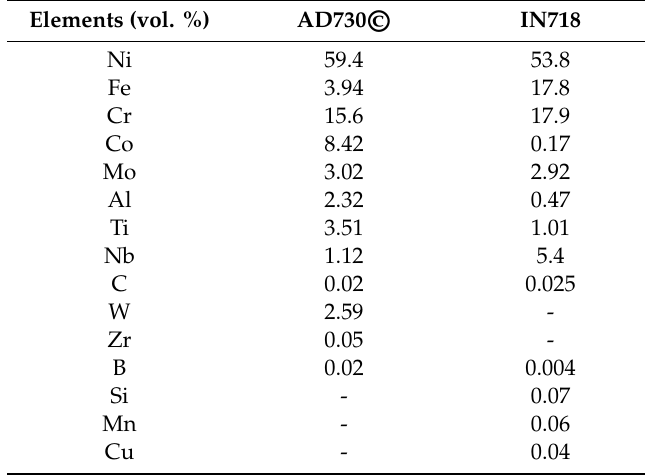
Table 1. Chemical compositions of AD730 TM and Inconel 718 (IN718)